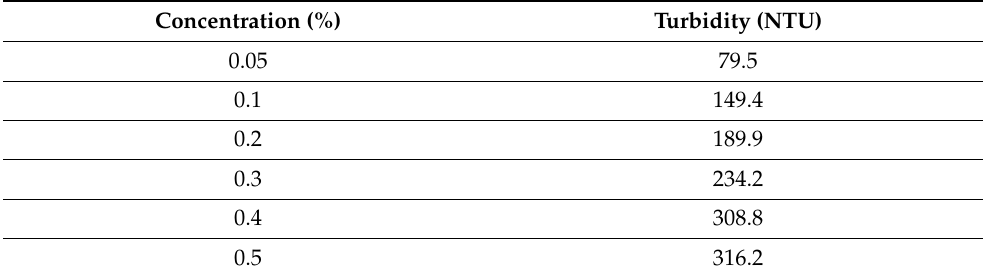
Figure 1. As-synthesized surfactant (ULCB) when diluted at different concentrations in seawater. Table 1. Turbidity value for as-synthesized surfactant.